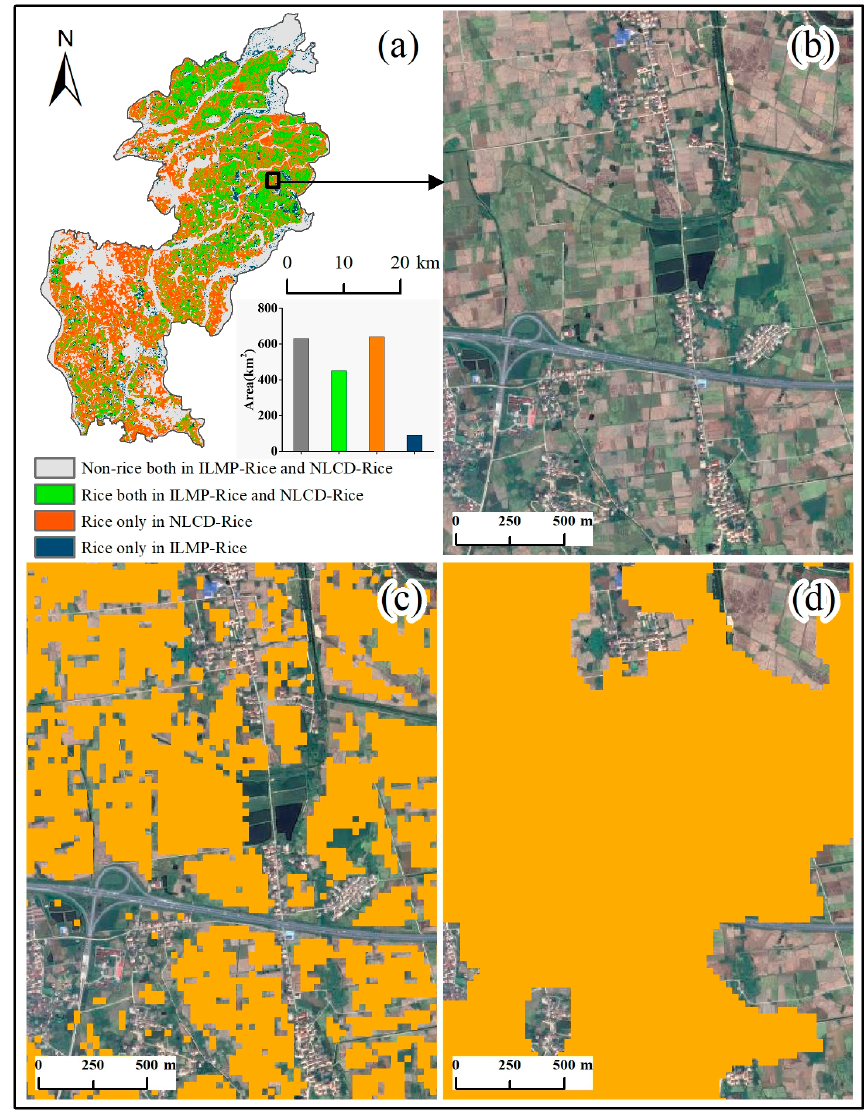
Figure 10. Comparison between ILMP-Rice and NLCD-Rice for 2015 in Nanchang County. ( a ) The statistics of four types of pixel considered (non-rice in both ILMP-Rice and NLCD-Rice; rice only in NLCD-Rice; both rice in ILMP-Rice and NLCD-Rice; and rice only in ILMP-Rice). ( b – d ) The details of the ILMP-Rice and NLCD-Rice data in a case region. ( b ) The high-resolution image from Google Earth on July 12, 2015, ( c , d ) The ILMP-Rice map and the NLCD-Rice map (in orange).